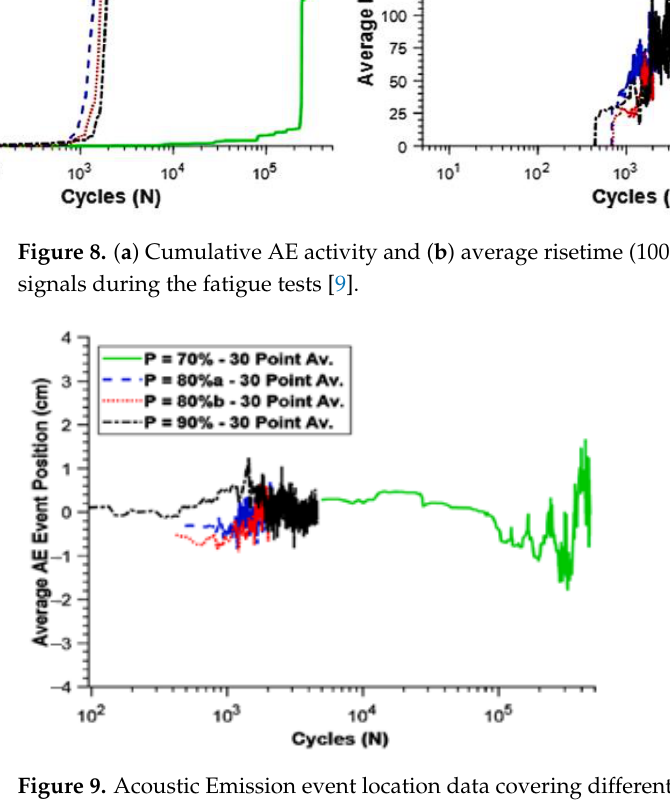
Figure 10. Fatigue lifetimes of all fatigue specimens based on different measurement methods [9]. 4. Conclusions The corner section of a square composite beam has been experimentally assessed by performing static and dynamic loading tests on V-shape specimens. Fatigue life curves have been developed for each loading case with runouts of 500,000 cycles. The location of failure, as observed via DIC in all test cases, was the result of a combination of high lon- gitudinal and transverse tensile strains in the main bend region of the specimen. Such regions with this combination of strains were specifically susceptible to failure initiation and in all cases were the source of initial crack growth and delamination. Mitigating the occurrence of these types of strains through informed design, thereby ensuring that they remain at conservative levels, will help to ensure that the composite component retains its structural integrity. In conclusion, DIC and AE have showcased significant benefits over traditional strain gauge measurements, providing more conservative measurements of the time to failure. The added benefits of using these techniques are the ability of both